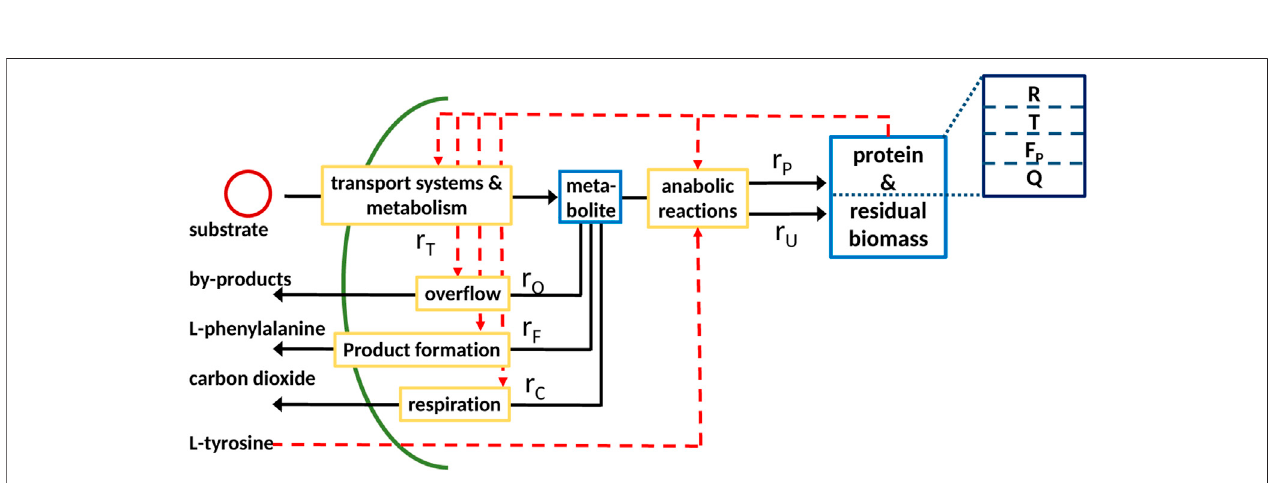
FIGURE 5 | Scheme of the coarse-grained model expanded to include the formation of L-phenylalanine, respiration r C , and residual biomass U .